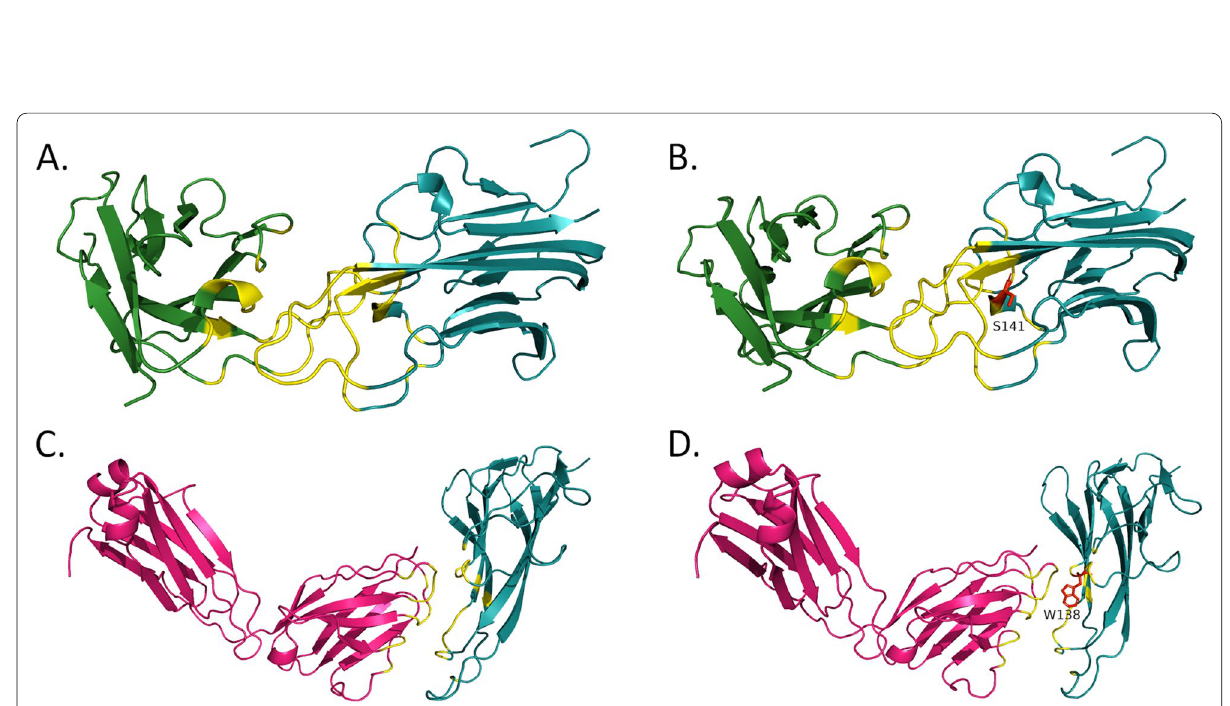
Fig. 6 Interactions of TNFA with golimumab and infliximab. Interactions between TNFA and the heavy chain of golimumab in the wild-type ( A ) and TNFA Y141S variant ( B ) structures. Interactions between TNFA and the light chain of infliximab in the wild-type ( C ) and TNFA R138W variant ( D ) structures. Forest green- antibody heavy chain; hot pink- antibody light chain; deep teal- TNFA; yellow- interface; red- mutated residue